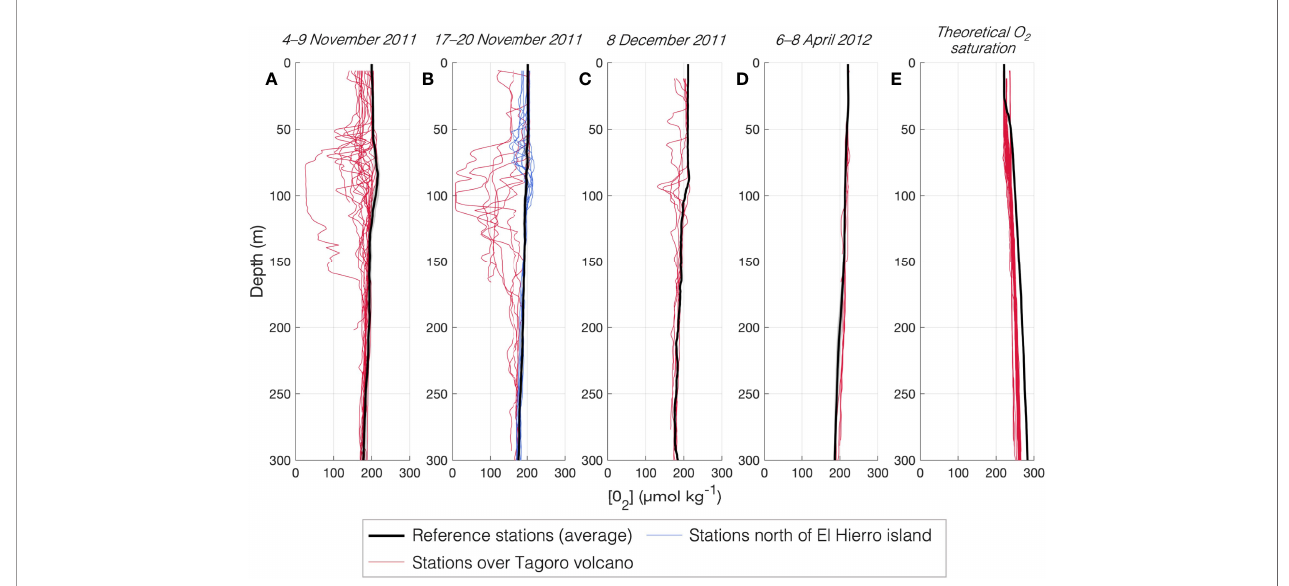
FIGURE 2 | Vertical pro fi les of dissolved oxygen during the eruptive stage, measured during cruises 1,2,3,4 ( A – D , respectively). Black line represents a reference pro fi le, with standard deviation. Panel (E) shows the theoretical saturation of dissolved O 2 based on temperature and salinity data, for the reference pro fi le (black line) and for all the affected stations measured during cruises 1,2,3,4 (red lines).